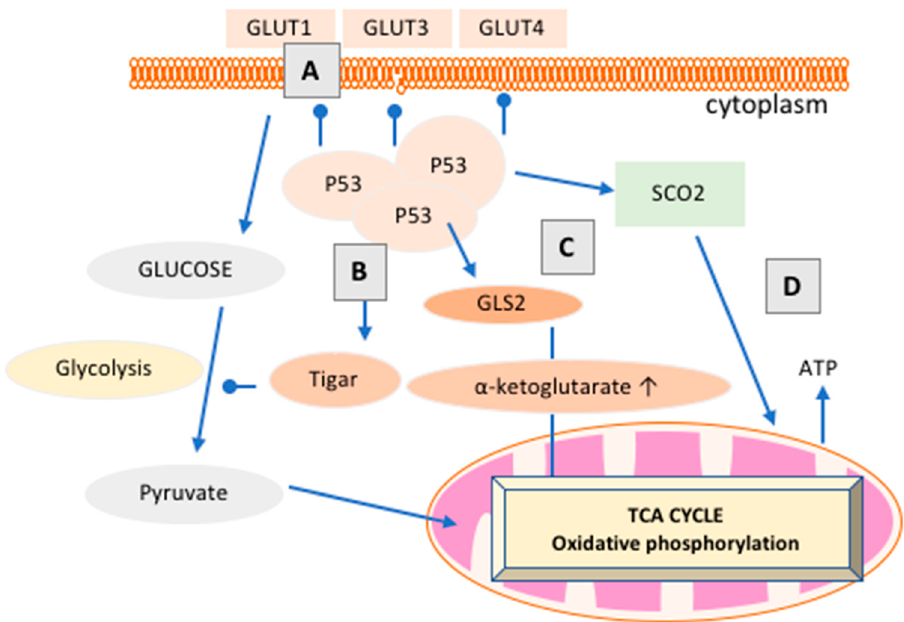
Figure 2. p53 balances glycolysis and mitochondrial respiration. The roles of p53 in cancer metabolism include: ( A ) suppressing the first step of glycolysis by direct downregulation of glucose-type transporters (GLUT) including GLUT 1, GLUT3, and GLUT4 receptors, which are typically overexpressed in the membranes of cancer cells to facilitate glucose flux [110,133]; ( B ) negative regulation of glycolysis by increasing expression of TP53-induced glycolysis regulator (TIGAR) [133]; ( C ) regulation of glutaminase-2, leading to an increase in the metabolite α -ketoglutarate. This, in turn, promotes the TCA cycle and mitochondrial respiration [134]. ( D ) The upregulation of the cytochrome C oxidase (COX) complex, via p53 targeting the cytochrome c oxidase assembly protein, increases mitochondrial respiration. COX is a vital transmembrane protein that accepts oxygen in mitochondrial respiration [17]. This figure has been adapted from [1].